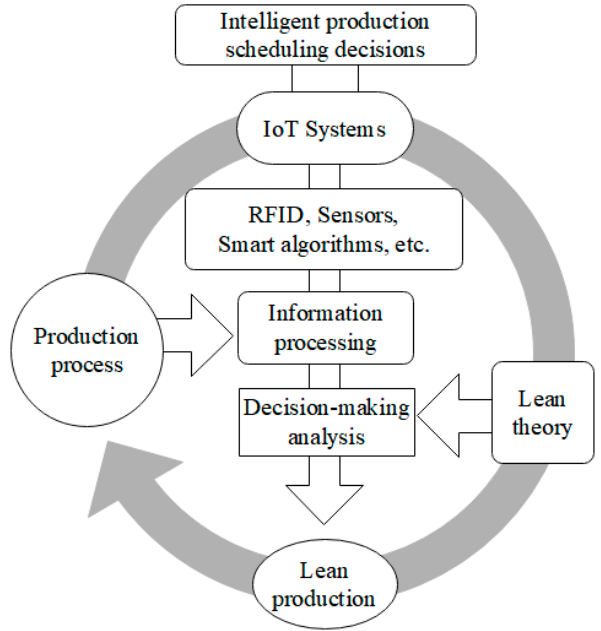
Figure 4. The operating mechanism of ICSPB-IoT in the component production stage.